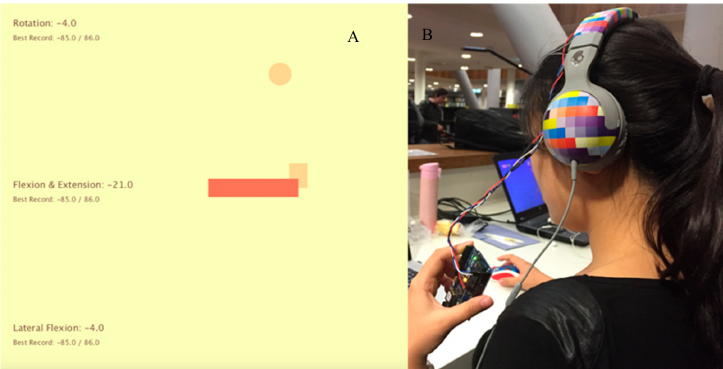
Figure 2. Exercise feedback exploration. ( a ) Real-time angulation data and the maximal angle reached are displayed on left side in degrees. The lengths of two bars represent, respectively, the tilt angle during Lateral bending (X-axis) and flexion and extension (Y-axis). A circle moves on a circular pathway whose position indicates the rotation angle during neck rotation (Z-axis). ( b ) The sensor is placed on the headphone and connected to Arduino by wire.